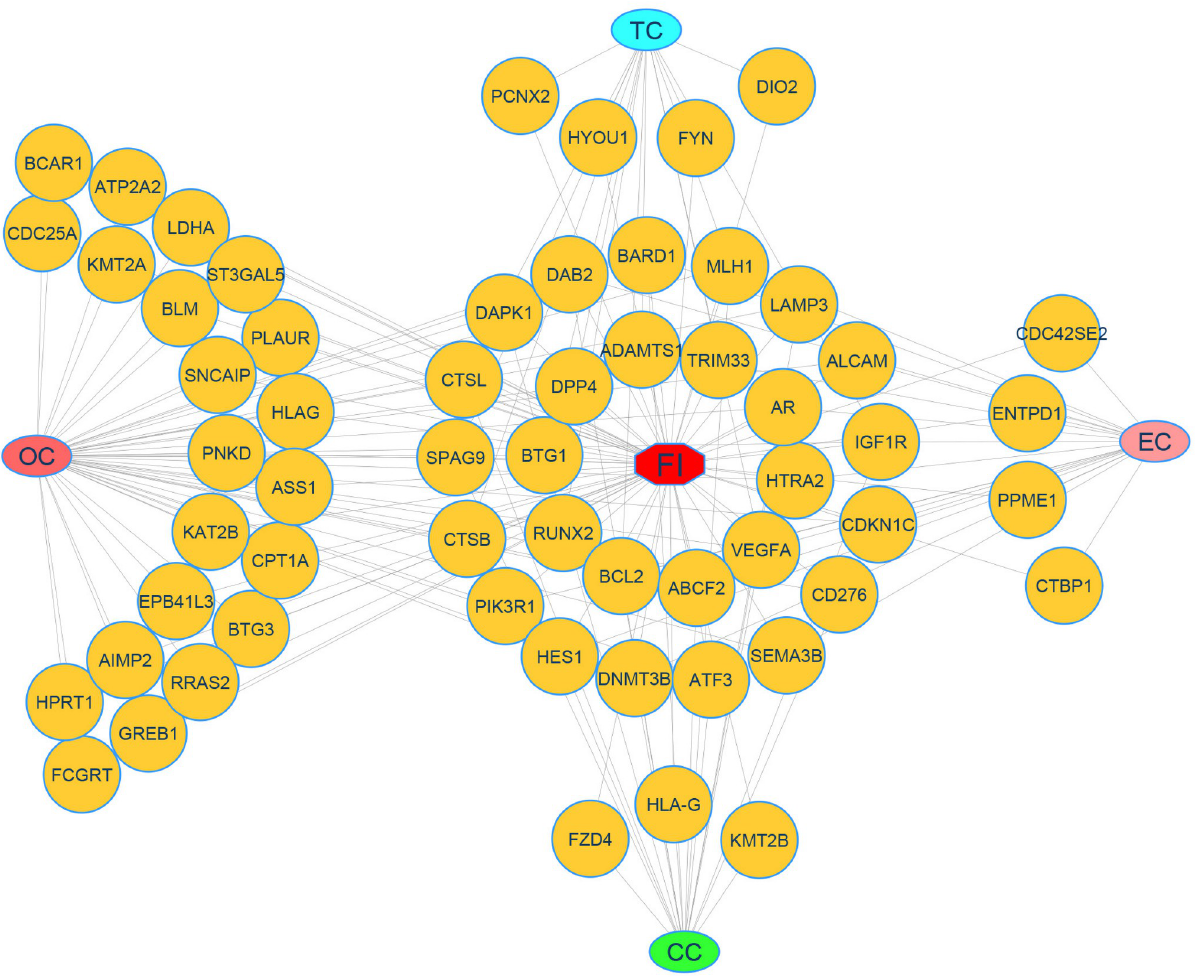
Fig 11. Gene-disease association analysis of DEGs of 4 cancerous risk factors with FI using OMIM and DisGNET databases. Ellipse-shaped nodes represent risk factors, and round-shaped nodes represent DEGs. Deep-green color and Round-shaped indicates common genes between FI and four cancerous risk